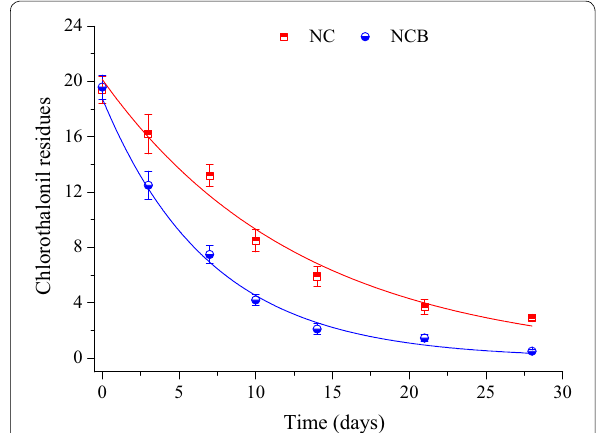
Fig. 1 Degradation of chlorothalonil in the soil after different treat- ments. All values are mean SD of three replicates ±